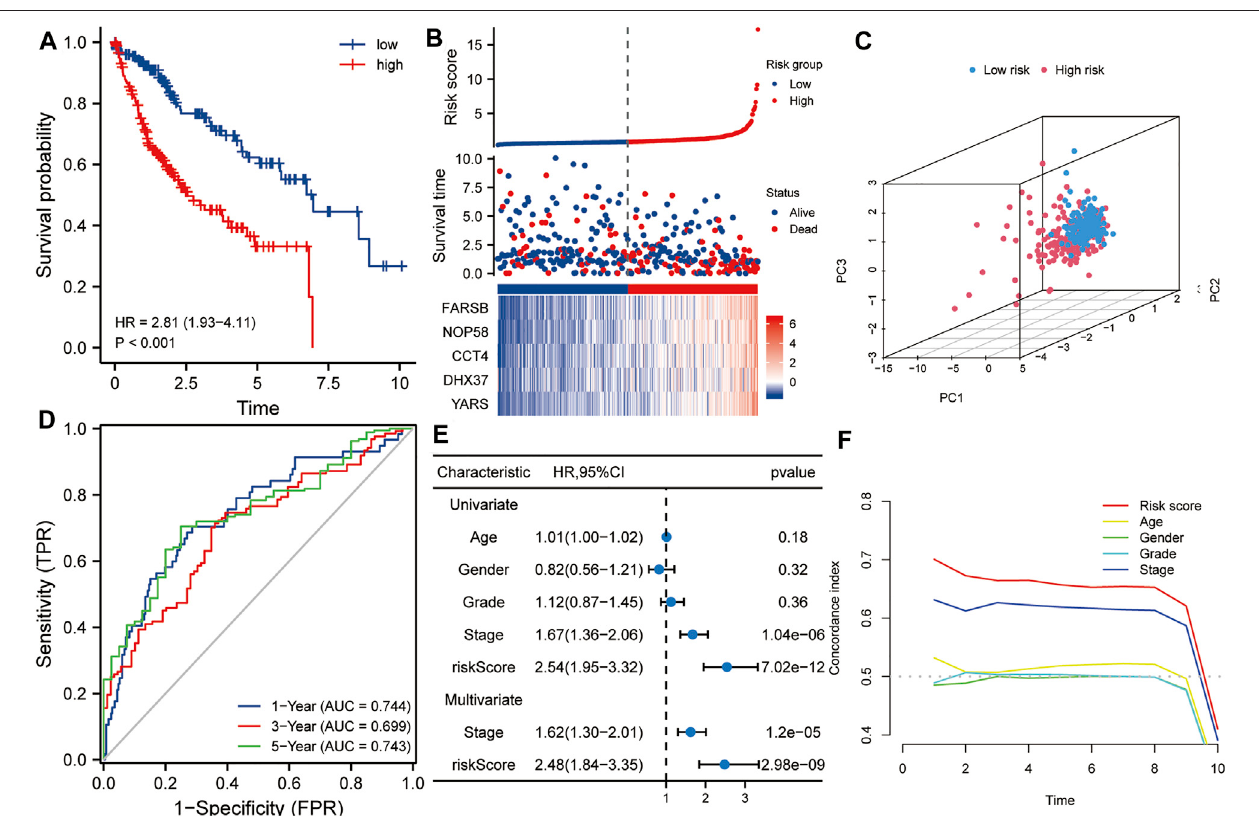
FIGURE3| Theriskscorepredictspoorsurvivalinthetrainingset. (A) Kaplan-MeieranalysisshowedthatHCCpatientswithhigherriskscoreshadaworseoverall survival rate. (B) The risk score distribution, survival pro fi le and heat map ofpatients in the high- and low-risk groups in the training set. (C) Principal component analysis suggested that risk score could be used as a new dimension to evaluate the prognosis of HCC patients. (D) The ROC curve showed the prediction ef fi ciency of the risk scoreinthetrainingset(AUC > 0.699). (E) UnivariateandmultivariateCoxregressionanalysisshowedthatriskscorewasanindependentriskfactorforOSinHCC patients. (F) The tROCanalysisshowed that the predictive power ofrisk score was signi fi cantly higher than that ofother clinical characters. HR, hazard ratio; OS, overall survival; tROC, time-dependent receiver operating